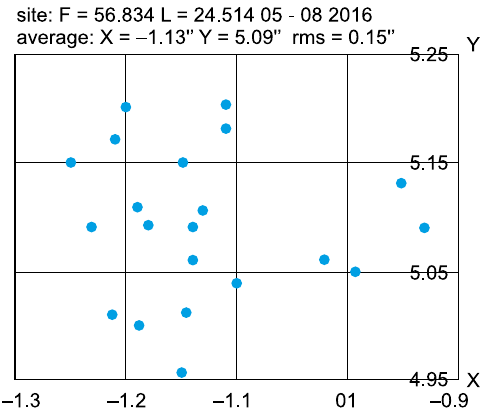
determination.Fig. 8. Vertical deflection values in the test site (May–August 2016), in arc seconds. Each point is result of one observation session, consisting of 100–200 frames in 10–20